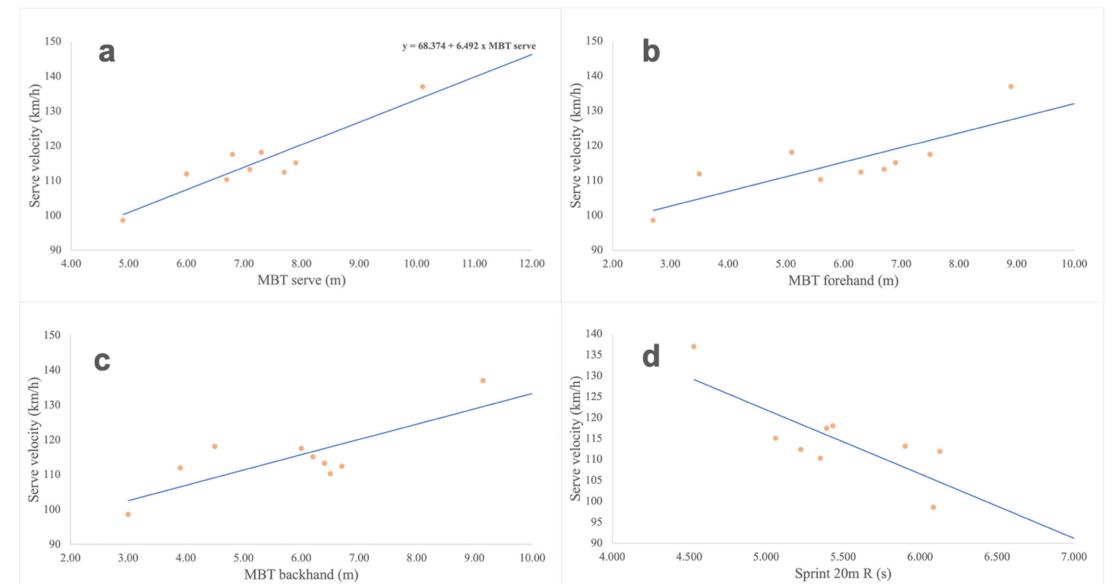
Figure 4. Relationship between the medicine ball throw test simulating a serve ( a ), forehand ( b ), backhand ( c ) and sprint of 20 meters with racket ( d ) with the serve velocity